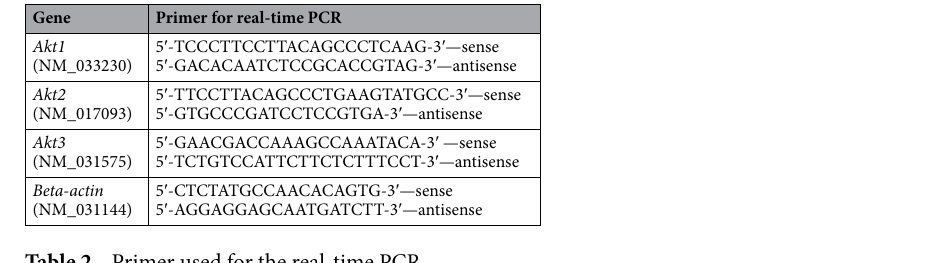
Table 2. Primer used for the real-time